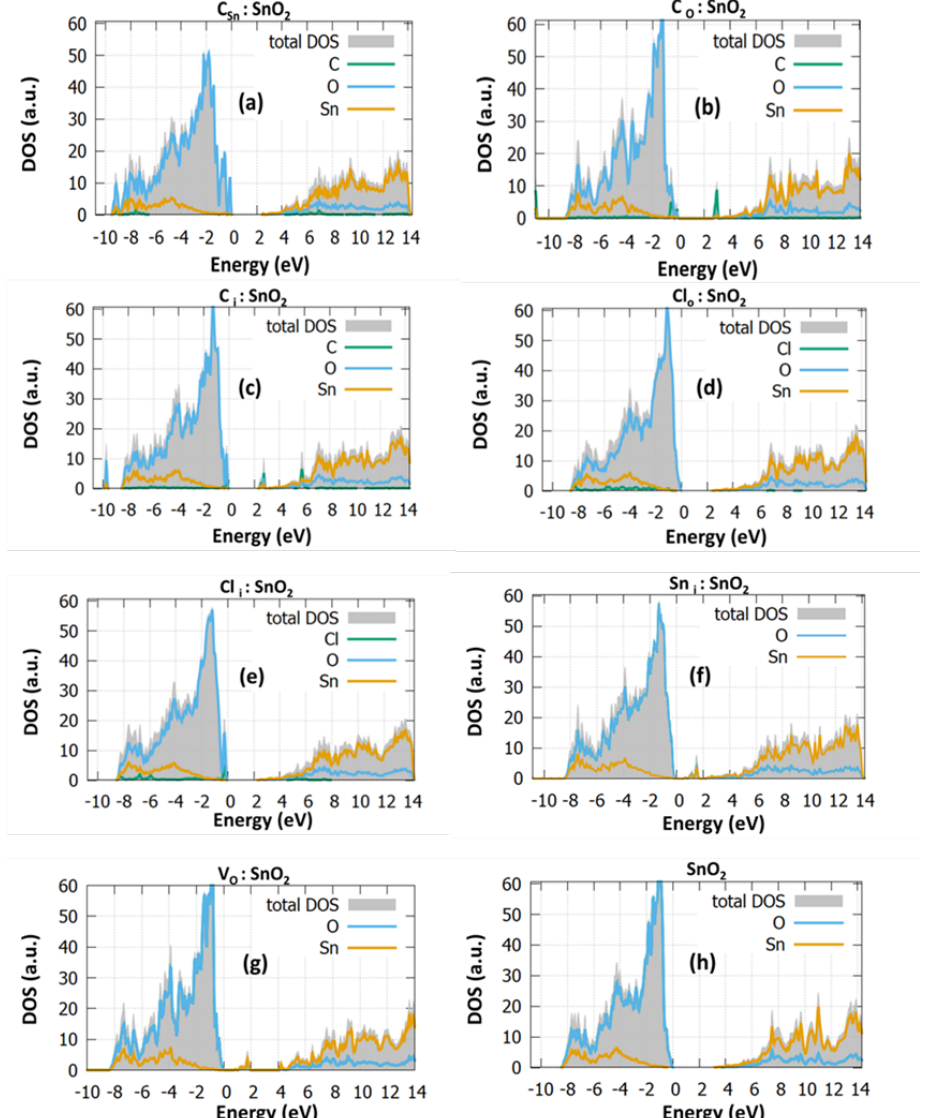
Figure 2. The total density of states (DOS) and the projected density of states (PDOS) of ( a ) C Sn : SnO 2 , ( b ) C O : SnO 2 , ( c ) C i : SnO 2 ( d ) Cl O : SnO 2 [14], ( e ) Cl i : SnO 2 [14] , ( f ) Sn i : SnO 2 , ( g ) V O : SnO 2 and ( h ) undoped SnO 2 .